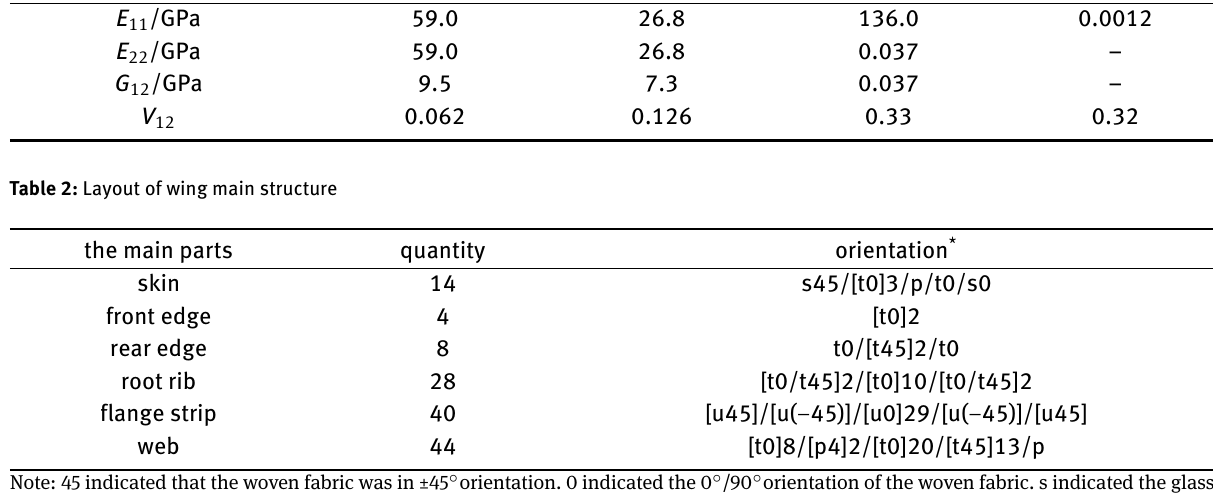
Table 1: Mechanical property of materials mechanical properties